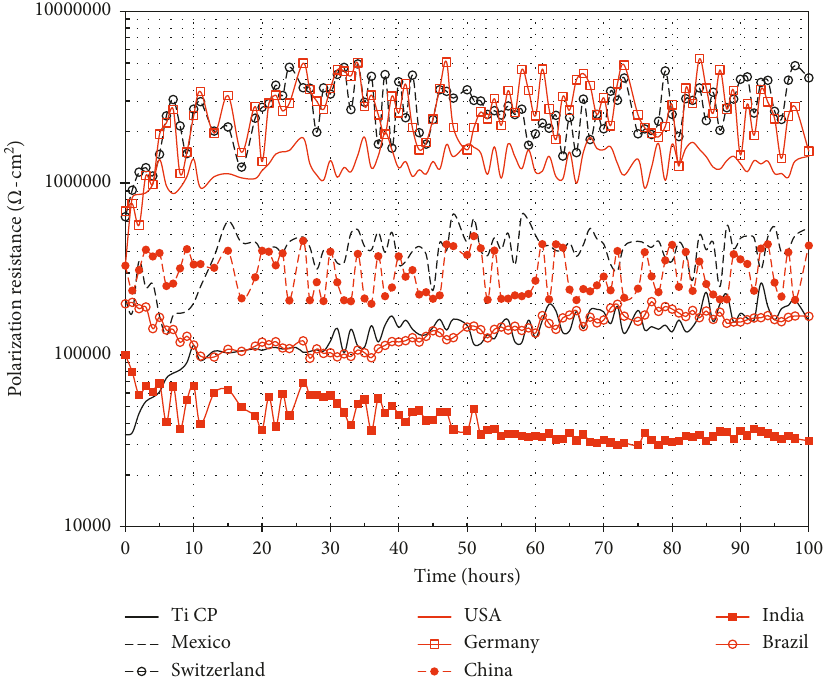
Figure 5: LPR measurements of the biomaterials for 100hours in a 0.9% NaCl solution at 37 °